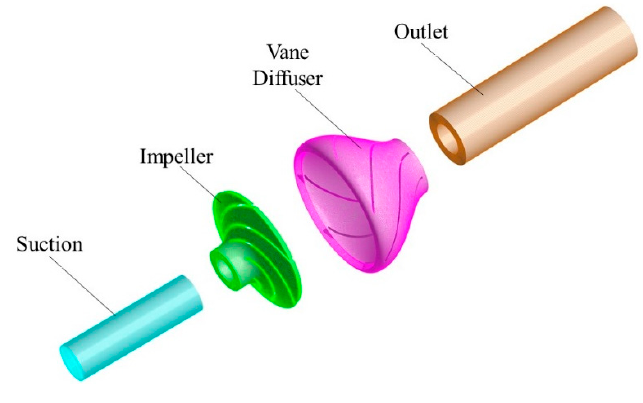
Figure 4. Mesh of assembly.